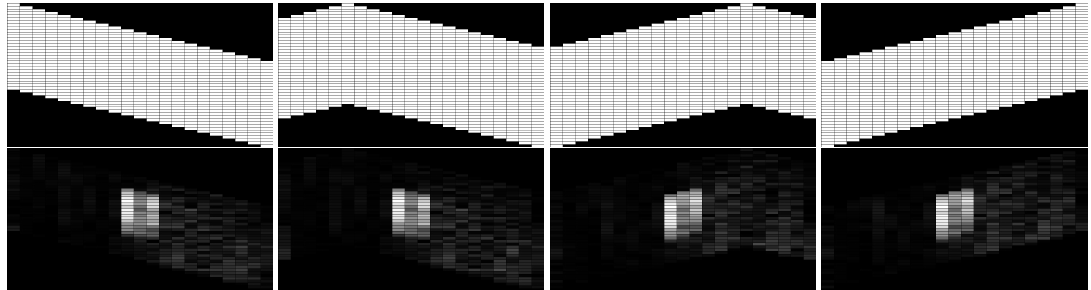
Figure 9. Distributed Salient Region Detection with Unbanlenced V-shape.